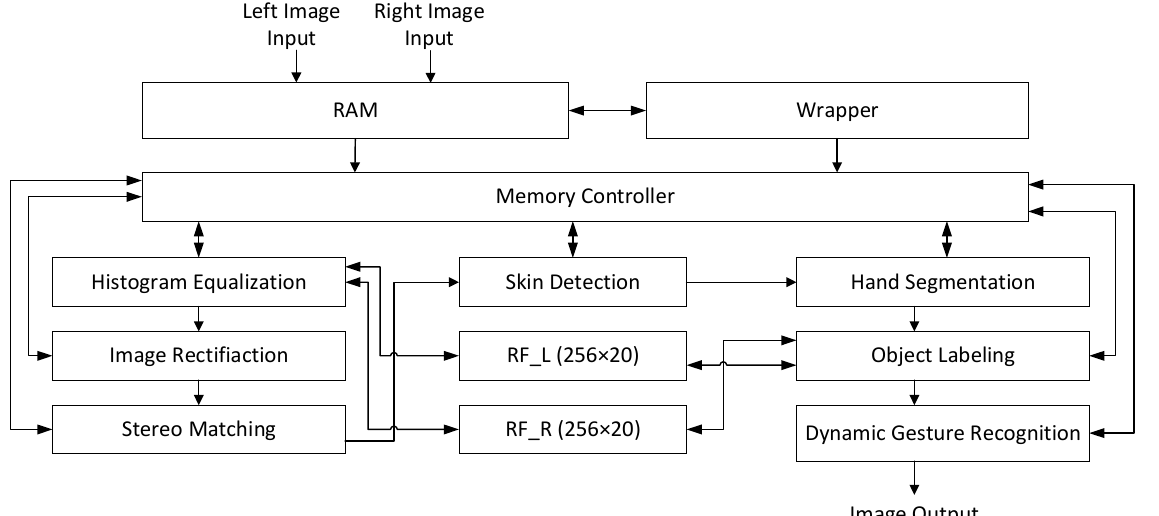
Figure 2. Block diagram of the proposed system.